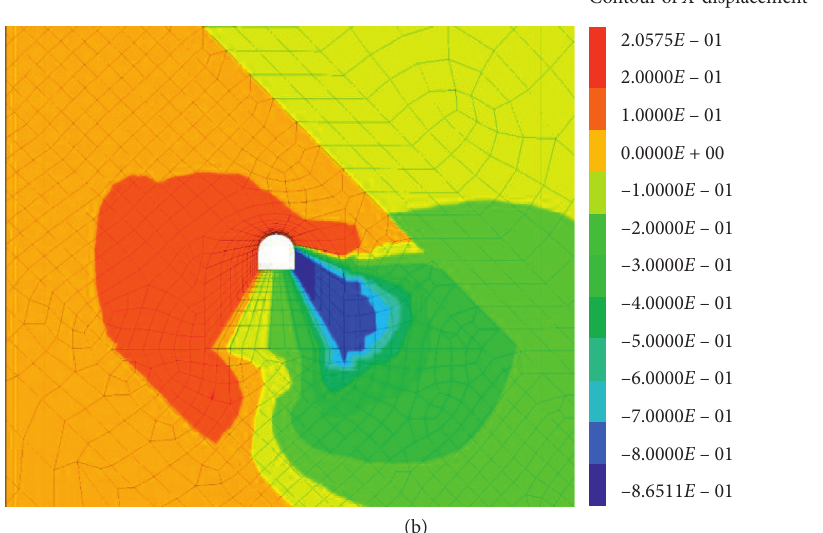
Figure 3: Nephogram of horizontal displacement of surrounding rock of roadway: (a) without support; (b) original